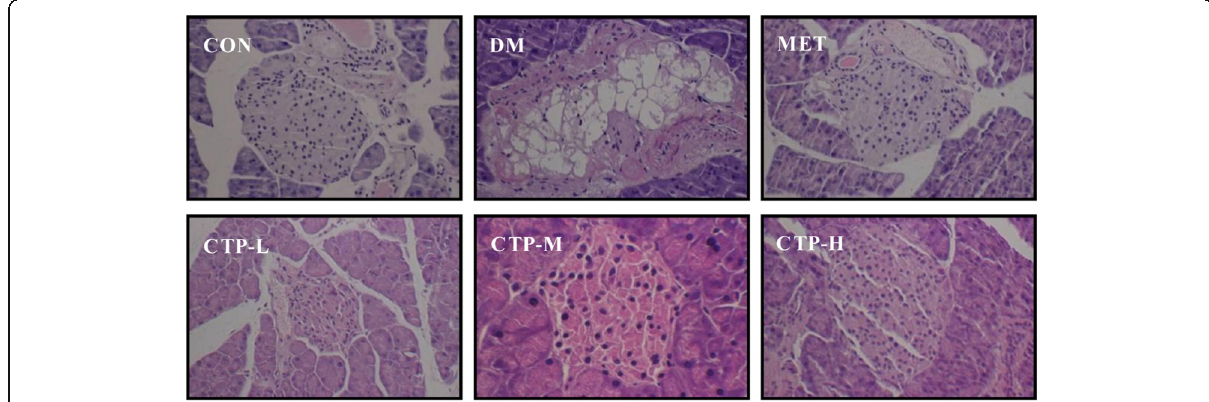
Fig. 4 HE staining showing the histopathological changes of the pancreas in diabetic mice treated with CTP for 28 days (200× magnification). The representative data from three independent experiments are